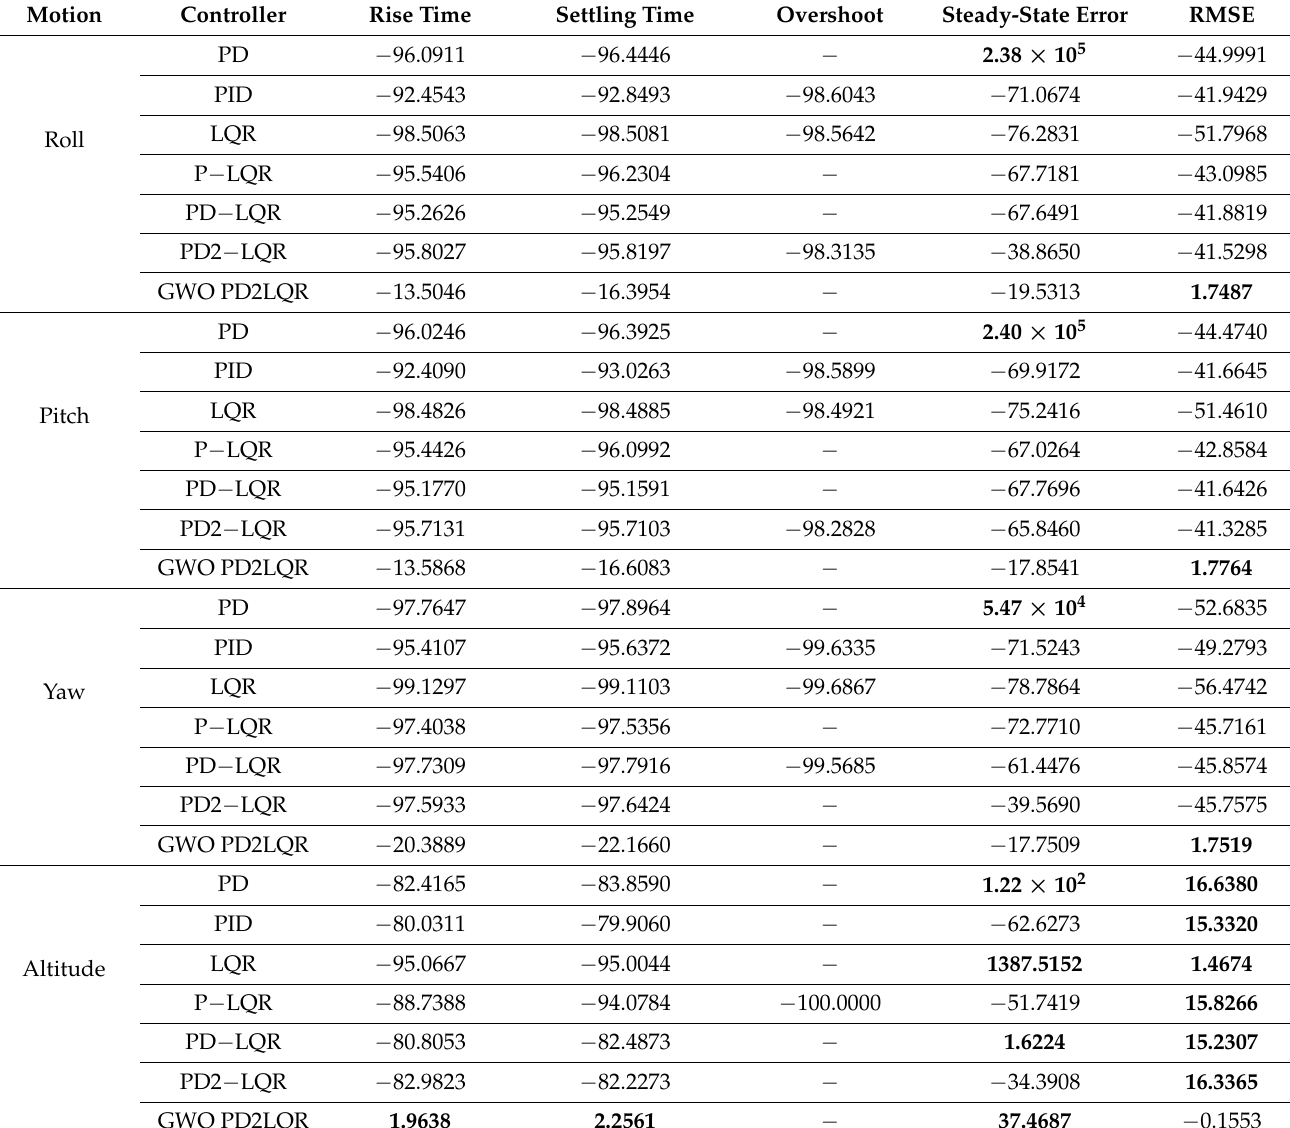
Table 4. Performance comparison of the controller (in